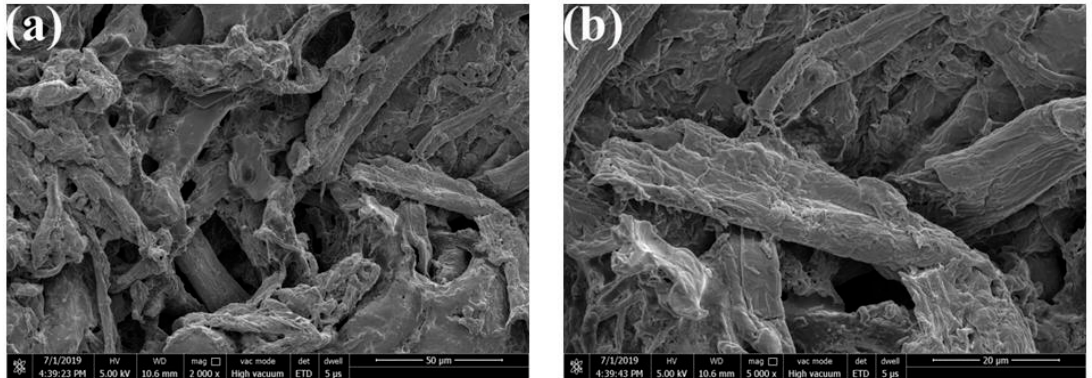
Figure 7. SEM images of surfaces etching of MAFC / PU in 1.5 wt% of the MAFC weight content (PU-FC-1.5) with ( a ) magnification at 2000, and ( b ) magnification at